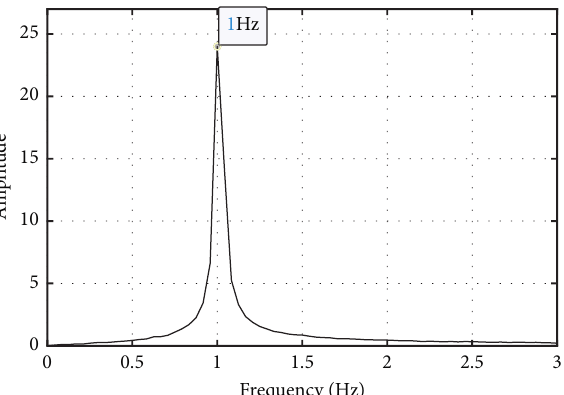
Figure 11: FTF of the two-DOF system.